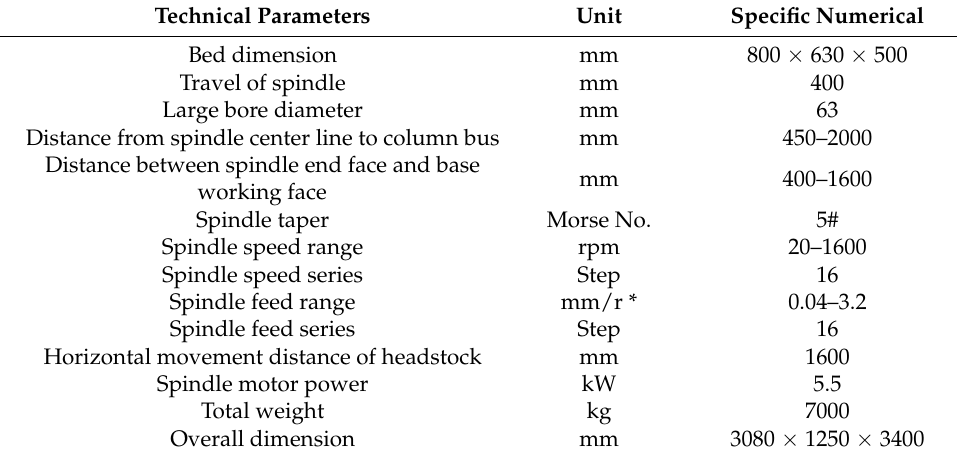
Table 6. Technical parameters of the Z30 radial drilling